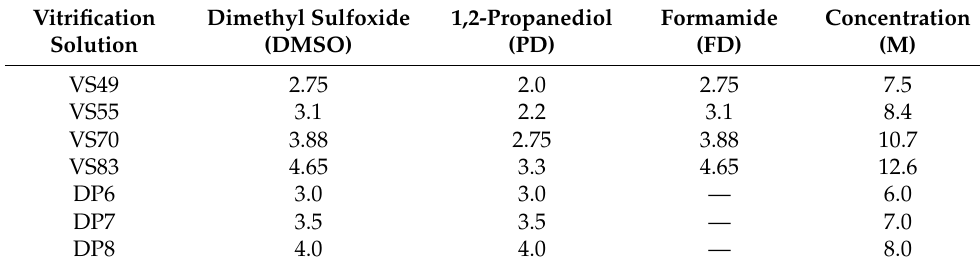
Table 1. Vitrification solution formulations.